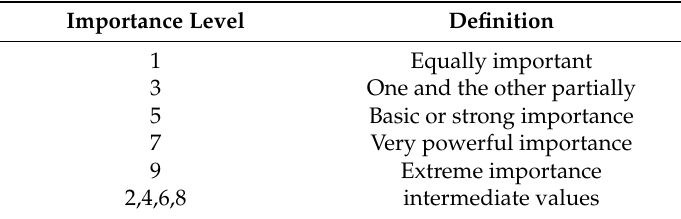
Table 1. The 1–9